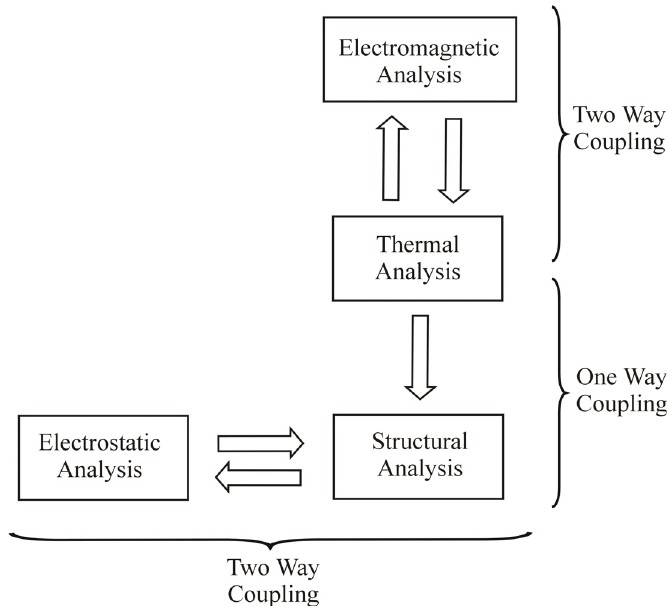
Figure 1. Flow chart for coupled field analysis procedure for RF MEMS